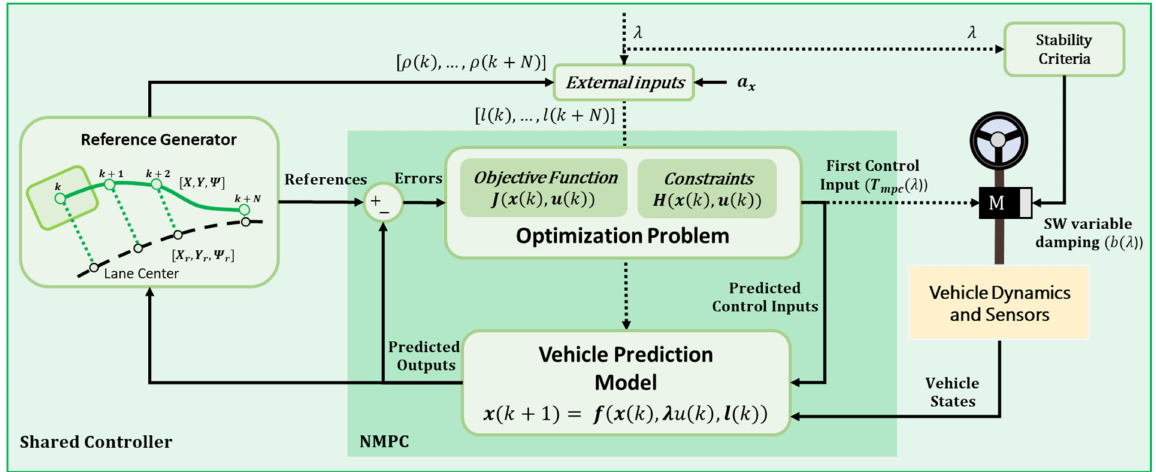
Figure 2. Shared controller block diagram based on